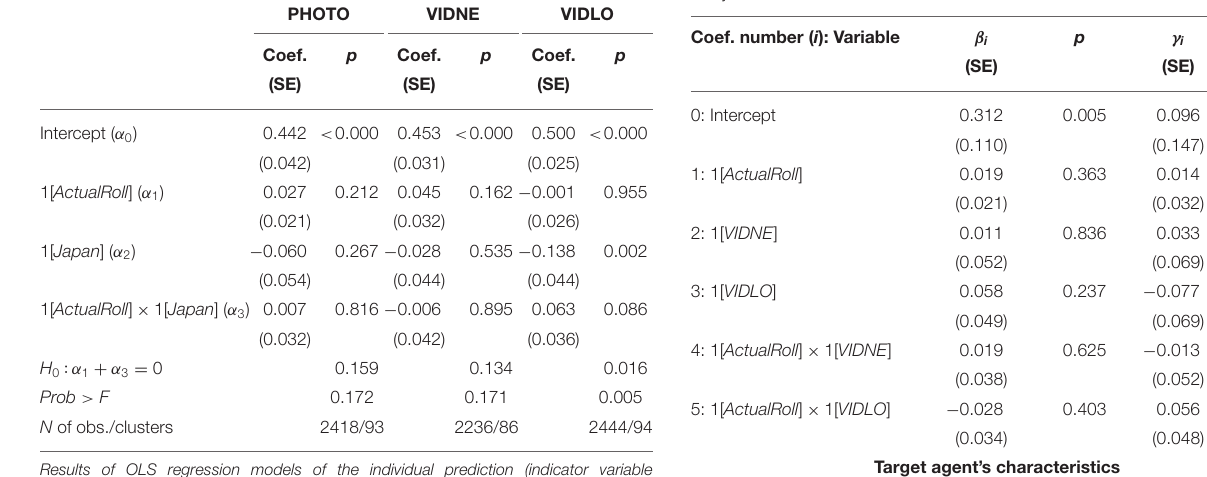
TABLE 4 | Facial characteristics and predictions across cultures: regression analysis. Coef. number ( i ):